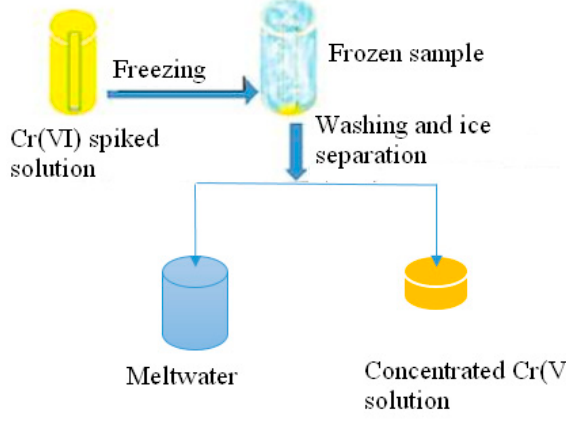
Figure 1. Overview of the experimental setup with ca. 20 mm diameter plastic tubes being inserted upside down in plastic beakers containing Cr(VI) contaminated